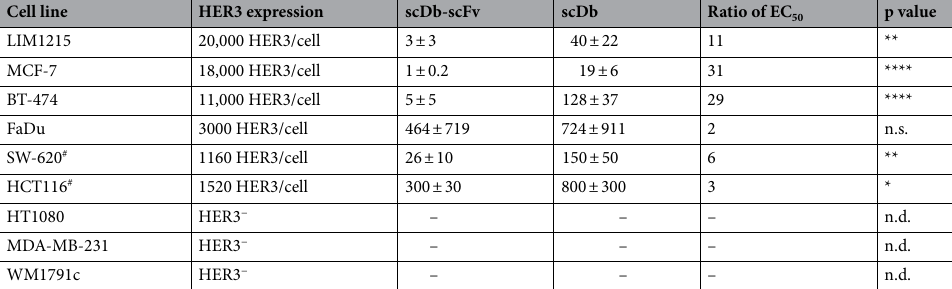
Table 3. T-cell mediated killing of tumor cells using scDb and scDb-scFv. EC 50 [pM], Mean ± SD, n = 2 with PBMCs from two donors for LIM1215, MCF-7, BT-474 and FaDu cells; n = 3 with PBMCs from one donor for SW-620, HCT116, HT1080, MDA-MB-231 and WM1791c cells. # For the HER3 low-expressing cell lines SW-620 and HCT116 the extrapolated values under the detection limit of 1900 molecules/cell (Qifikit) are depicted. *p < 0.05; **p < 0.01; ****p < 0.0001; n.s. p > 0.05; n.d., not